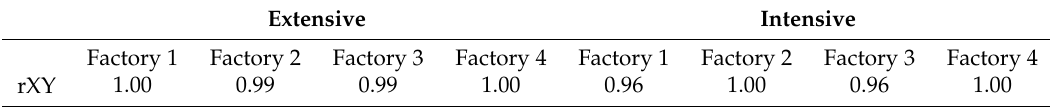
Table 9. The Pearson correlation coefficient (rXY) for thermal resistance and thickness. Extensive Intensive Factory 1